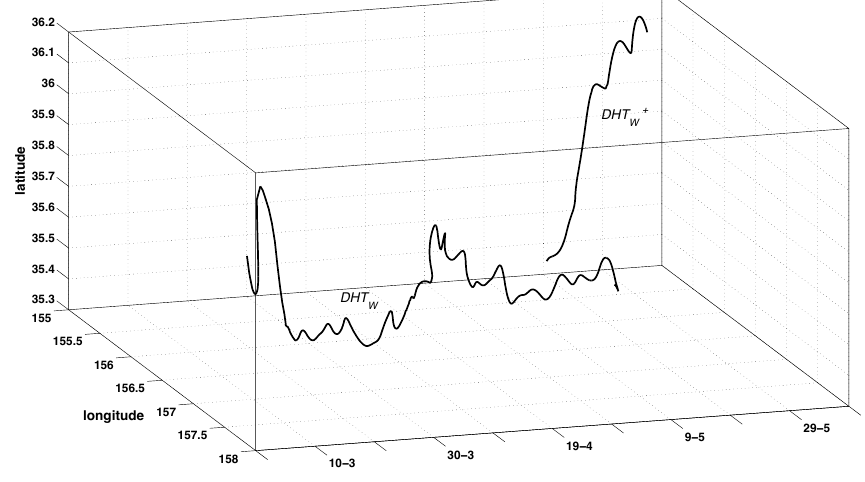
Fig. 12. Path of limit coordinates for DHT W and DHT +